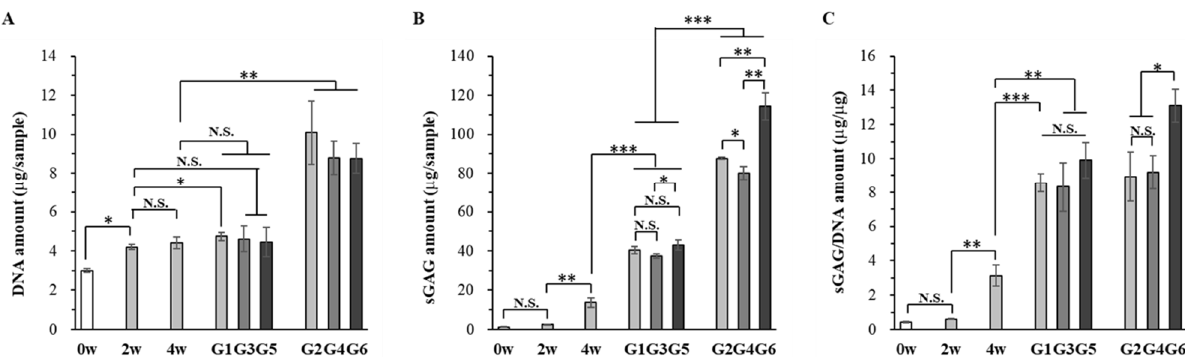
Figure 5. ( A ) DNA quantification, ( B ) sGAG amount quantification, and ( C ) sGAG/DNA ratio during in vitro culture for 8 weeks and in vivo subcutaneous implantation for 4 weeks. Data are shown as the mean ± SD (n = 3). Significant difference: *, p < 0.05; **, p < 0.01; ***, p < 0.001.